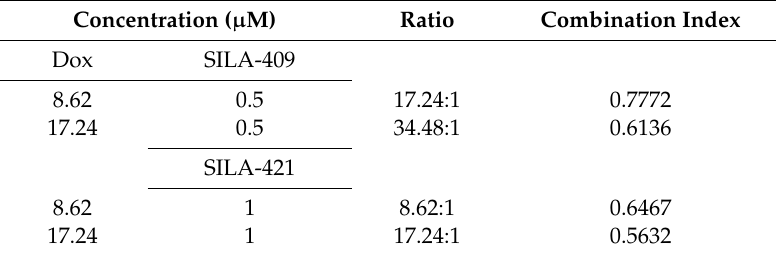
Table 1. Combination of disiloxanes with Dox against LoVo / Dx cell